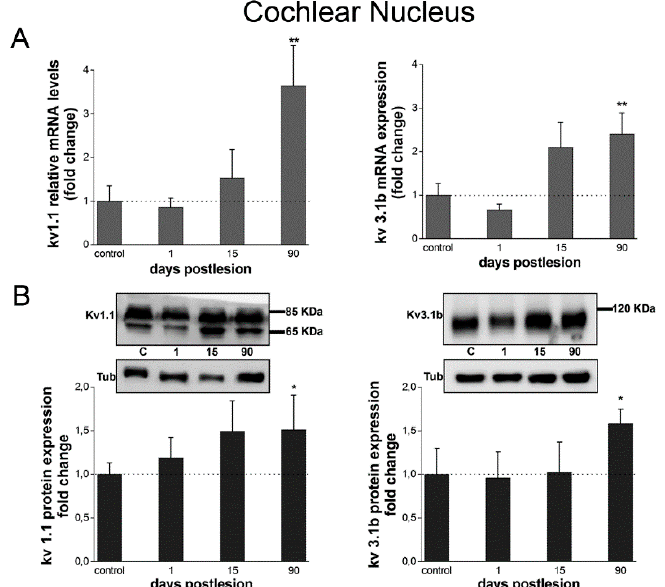
Figure 3. Kv1.1 and Kv3.1b gene and protein expression increase at long-term after cochlear lesion in the CN. ( A ) Kv1.1 and Kv3.1b mRNA levels at di ff erent time points after cochlear lesion analyzed by qRT-PCR. The bar chart shows mRNA levels relative to controls. ( B ) Kv1.1 and Kv3.1b protein expression levels detected by Western blot. Each image shows protein immunoreaction for each Kv in the CN. The figure shows one representative image from four independent experiments. Tubulin was used as loading control. The bar chart represents quantification of signal intensities. Data are normalized to signal intensity for day 0. Data are expressed as mean ± S.D. Asterisks show statistically significant di ff erences (* p < 0.05; ** p < 0.01), using one-way ANOVA, with Tamhane (qRT-PCR: Kv1.1, F 3,8 = 14.512, p < 0.01; Kv3.1b, F 3,8 = 18.498, p < 0.001) and Tukey (Western blot: Kv1.1, F 3,8 = 4.462 p = 0.04; Kv3.1b, F 3,8 = 4.425, p = 0.04;) post-hoc tests.